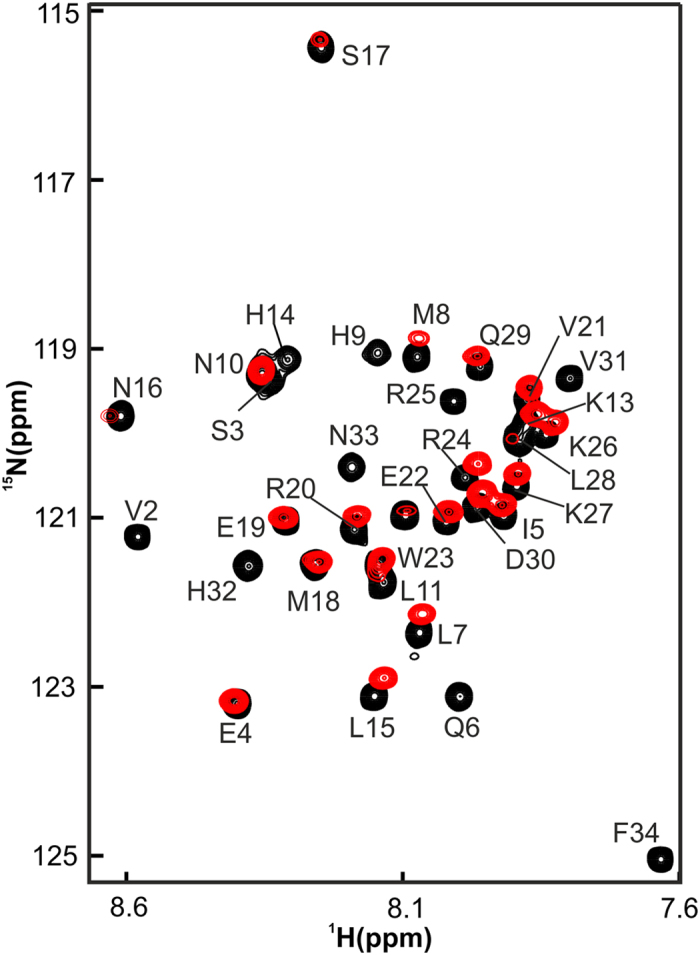
Binding of the Zn complex with PTH(1–34) mapped by NMR spectroscopy.Superimposed 2D 1H–15N HSQC spectra of 15N PTH(1–34) in the free state (black) and bound to the Zn complex (red).